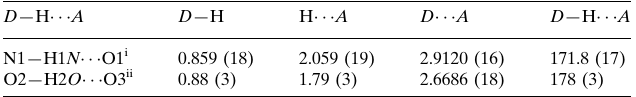
Hydrogen-bond geometry (A˚ , (cid:2)